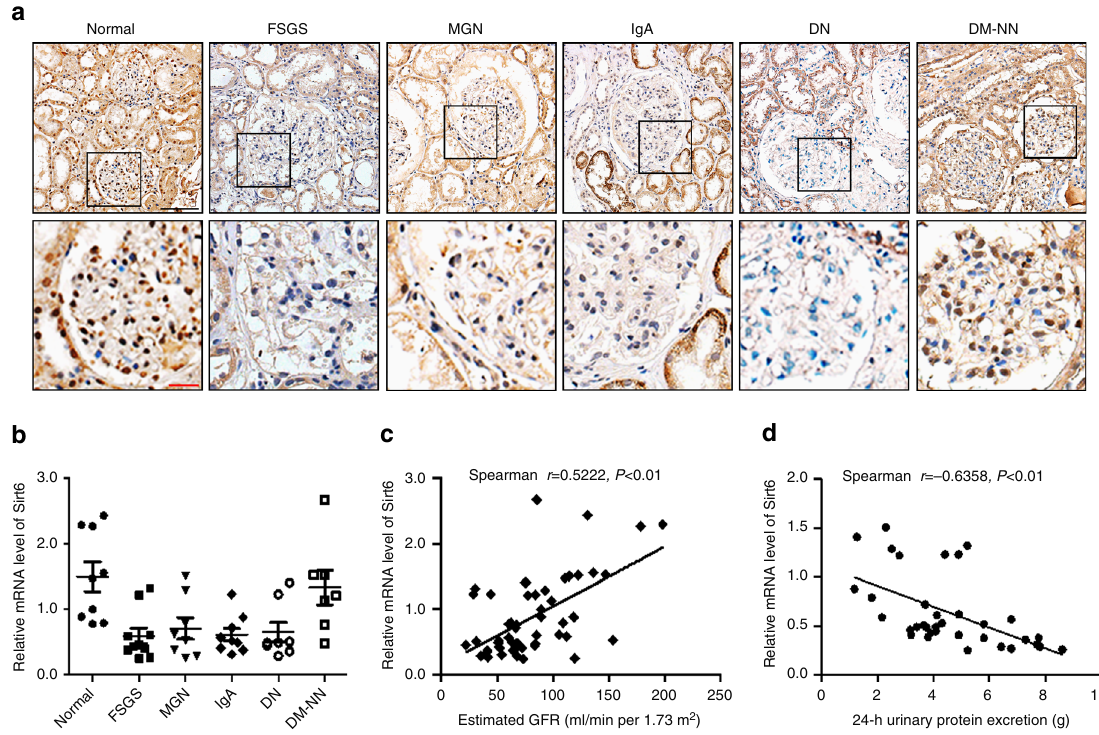
Fig. 2 Downregulation of Sirt6 in renal biopsies from patients with different forms of podocytopathies. a Representative photomicrographs of Sirt6 immunohistochemical staining in human renal cortical tissue from normal subjects ( n = 9), patients with focal segmental glomerulosclerosis ( FSGS , n = 10), membranous glomerulonephritis ( MGN , n = 8), IgA nephropathy (IgA, n = 9); diabetic nephropathy ( DN ) ( n = 8), or diabetic patients without nephropathy (DM-NN). Scale bar : black 100 μ m, red 25 μ m. ( n = 7). b Relative mRNA levels of Sirt6 in the renal biopsies from patients with different forms of podocytopathies. c Positive correlation (Spearman r = 0.5222, P < 0.01) between Sirt6 mRNA levels and estimated glomerular fi ltration rate (GFR) in all subjects. d Negative correlation (Spearman r = − 0.6358, P < 0.01) between Sirt6 mRNA levels and proteinuria in all subjects. * P < 0.05 vs. normal subjects. Data are expressed as means ± SE. One-way ANOVA followed by Tukey ’ s post-test for multiple comparisons was used for groups of three or